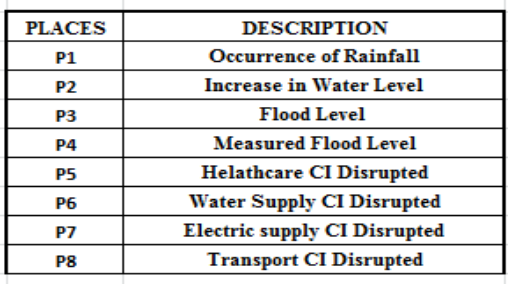
Table 2. Description of Places in HCI